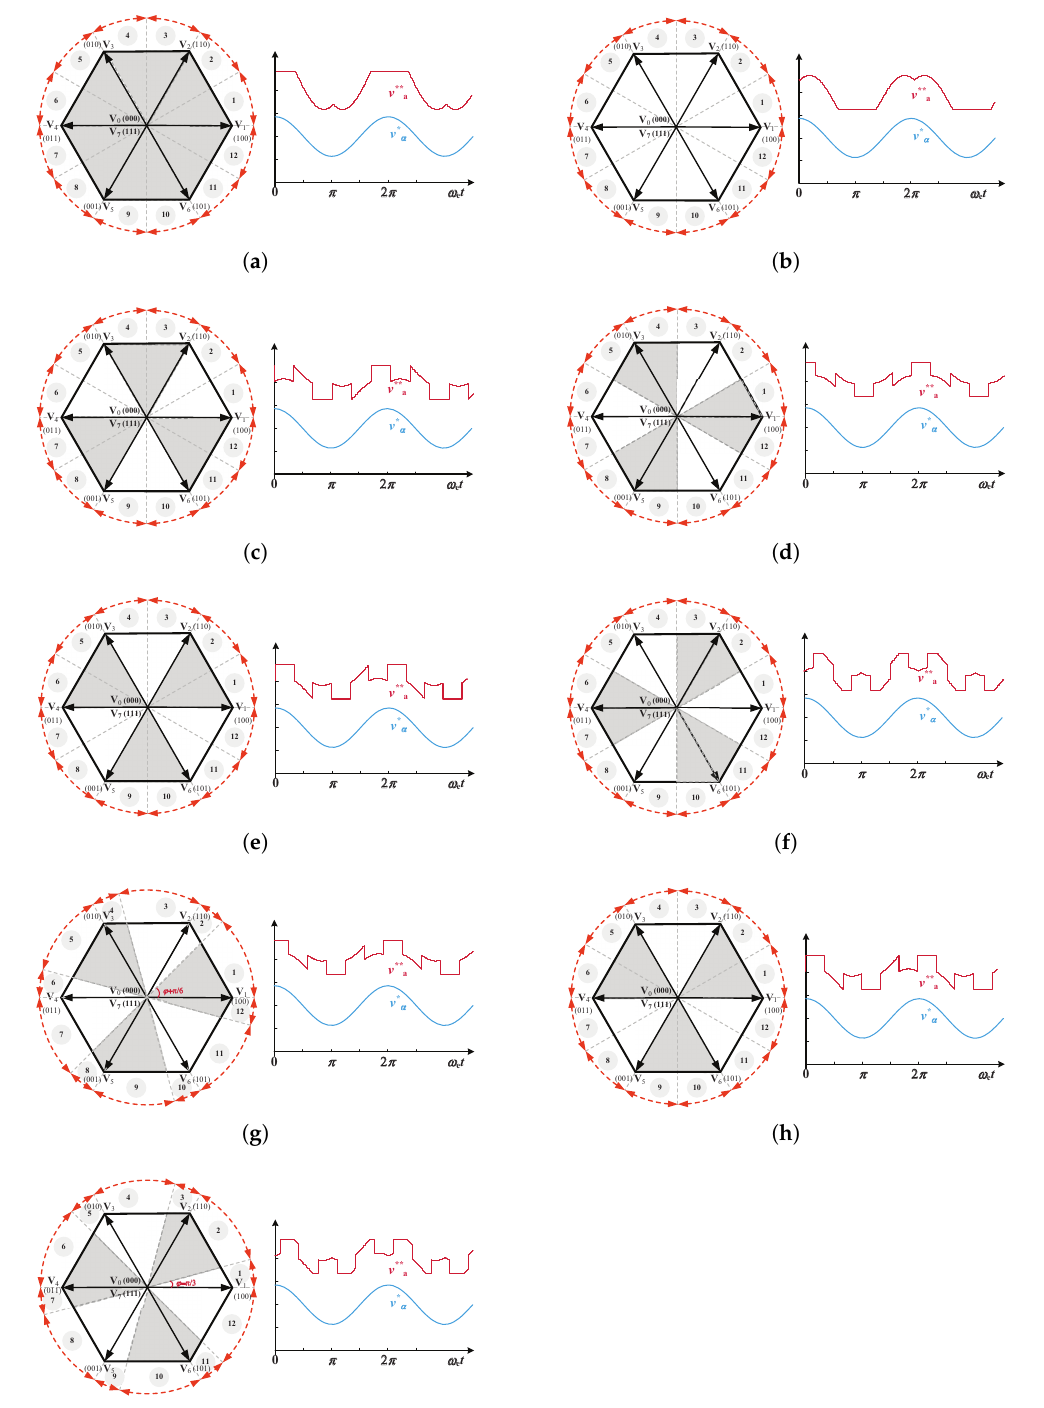
Figure 4. Modulation waveform of discontinuous carrier-based PWM ( a ) DPWMMAX, ( b ) DPWM- MIN, ( c ) DPWM0, ( d ) DPWM1, ( e ) DPWM2, ( f ) DPWM3, ( g ) MSL-DPWM when 0 ≤ ϕ ≤ 30 ◦ , ( h ) MSL-DPWM when 30 ◦ ≤ ϕ ≤ 60 ◦ , and ( i ) MSL-DPWM when 60 ◦ ≤ ϕ ≤ 90 ◦ . Note that the sectors filled in gray are designated as k = 1, while, in the remaining sectors, k =